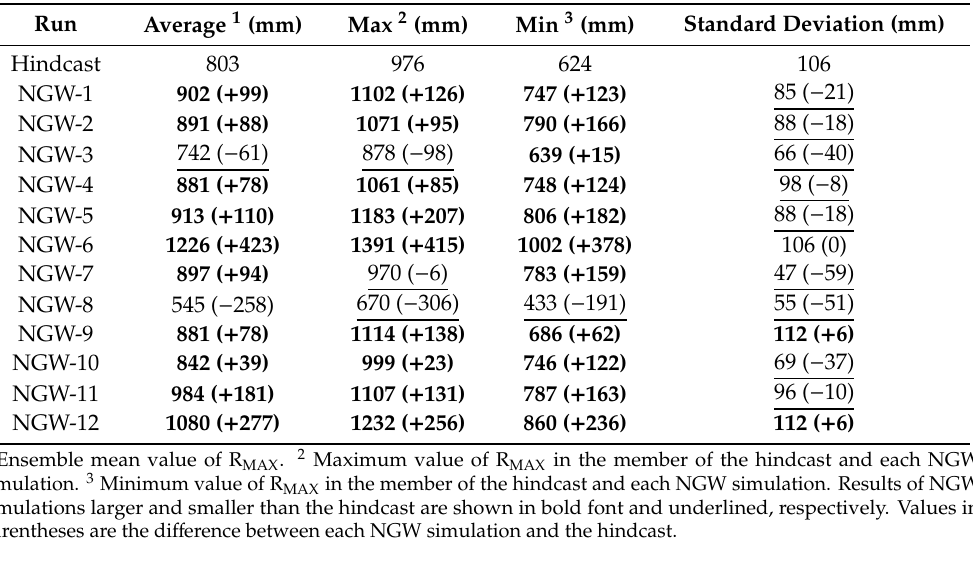
Table 8. The maximum total rainfall in D03 (R MAX ).